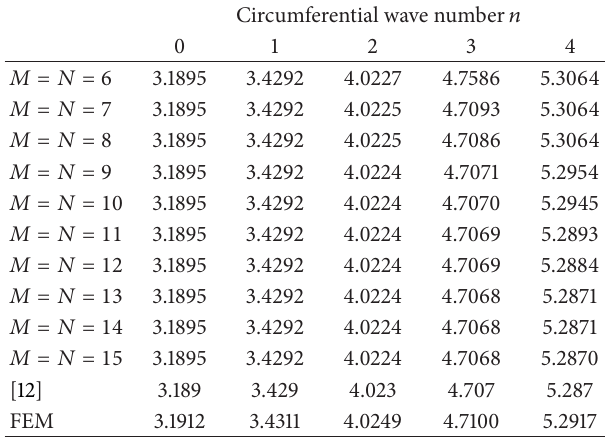
Table 1: Frequency parameters, Ω = 𝜔𝑏(𝜌(1 − V 2 )/𝐸) 1/2 , for C-C annular plates with various cutout ratios.